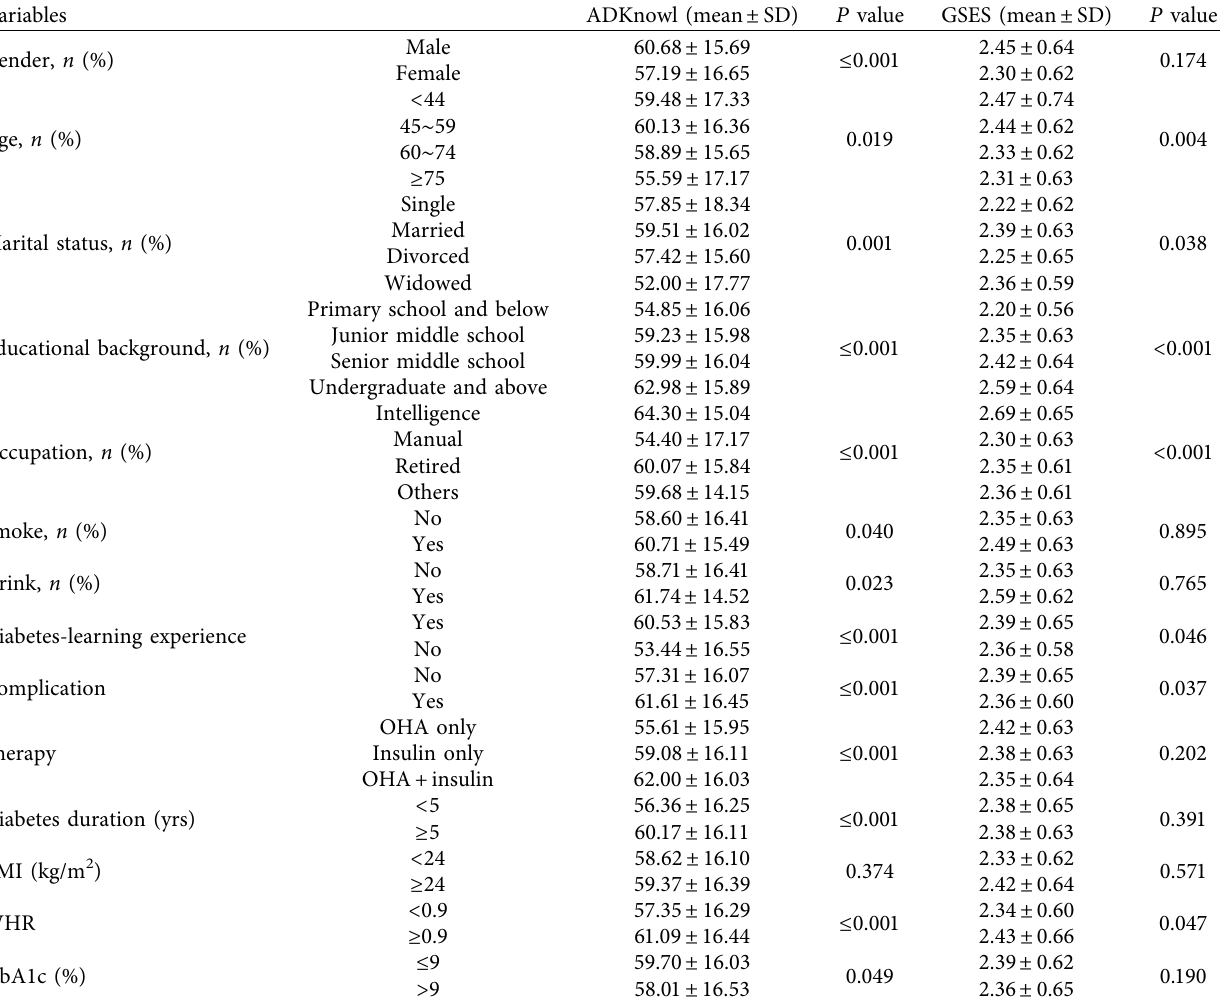
Table 4: Association between various factors and ADKnowl and